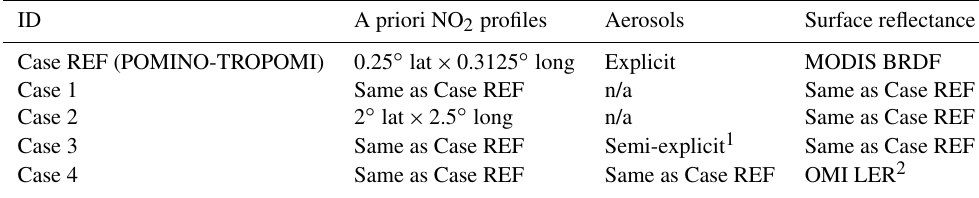
Table 1. Sensitivity experiments for the NO 2 retrieval based on the POMINO-TROPOMI algorithm (n/a: not applicable).